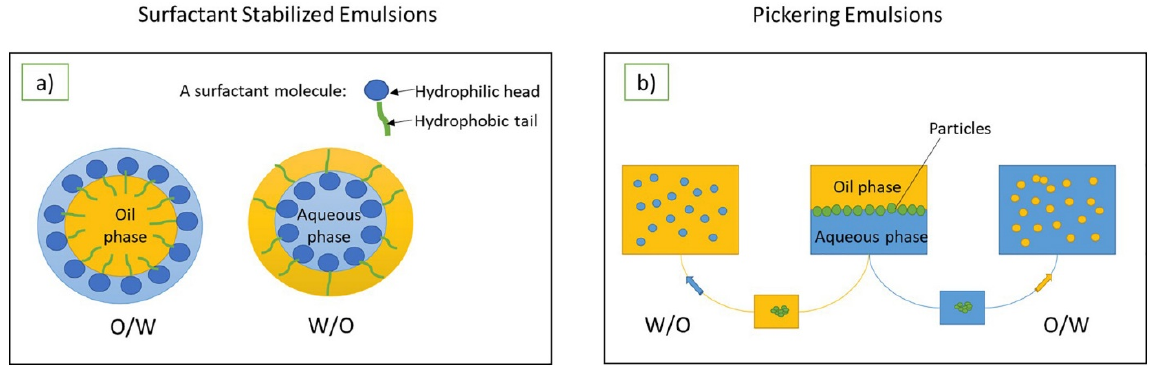
Figure 1. Sketch of the main features of surfactant-stabilized ( a ) and particle-stabilized ( b ) emulsions. Adapted from Venkataramani et al. [7], Copyright (2020), with permission from Elsevier.